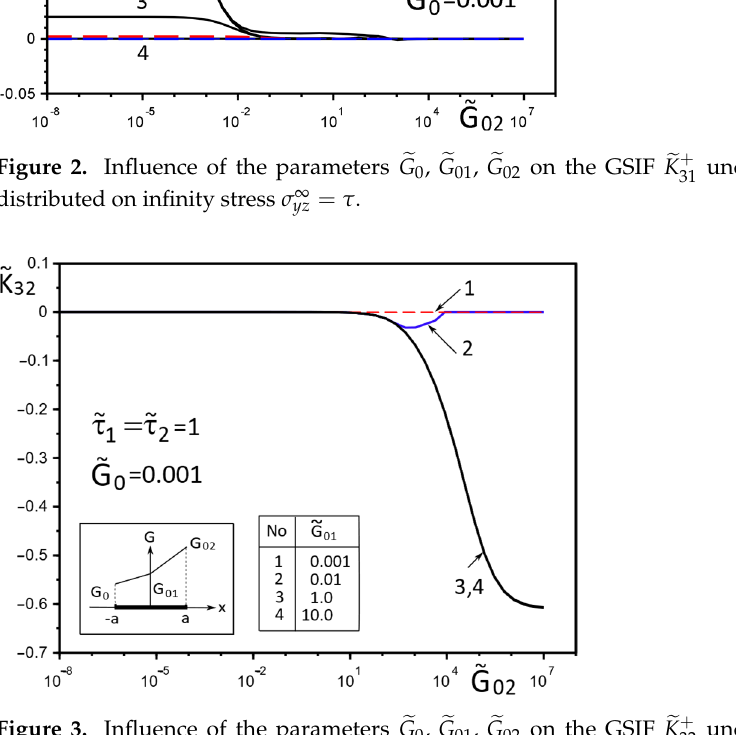
under the load, uniformly 32